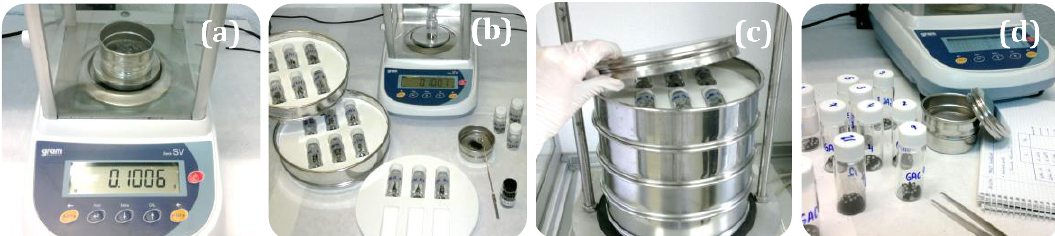
Figure 2. Depiction of materials and procedure for the mechanical strength evaluation of the samples: ( a ) a weighted sample was sieved using in 300 μm sieve and put in a vial; ( b ) 15 steel balls were also incorporated in the vial, which was then placed in a polymer mold; ( c ) the molds were placed in the sieve shaker during 20 min; ( d ) the sample was sieved again in a 300 μm sieve and the residue (the sample not converted to dust in the sieving step) was collected and weighed to calculate the sample remaining mass percentage (SRM%).